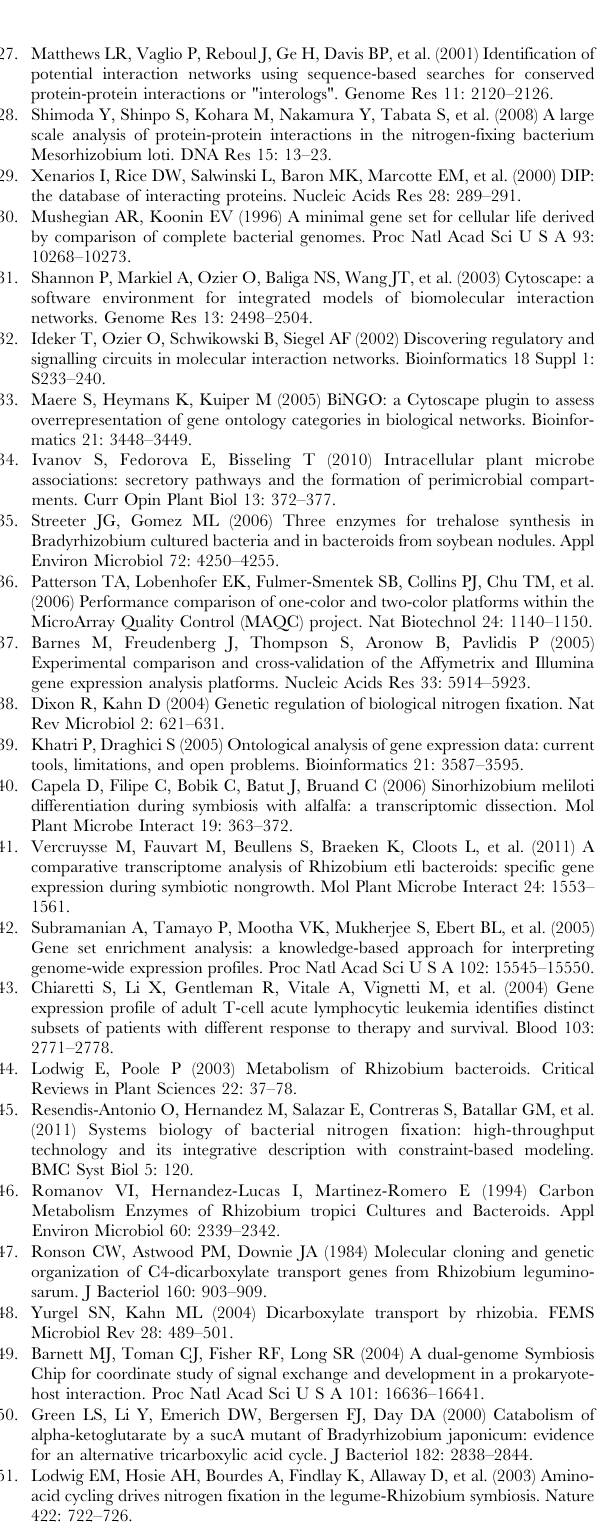
Table S11 Genes associated with c-di-GMP synthesis and degradation in M. huakuii